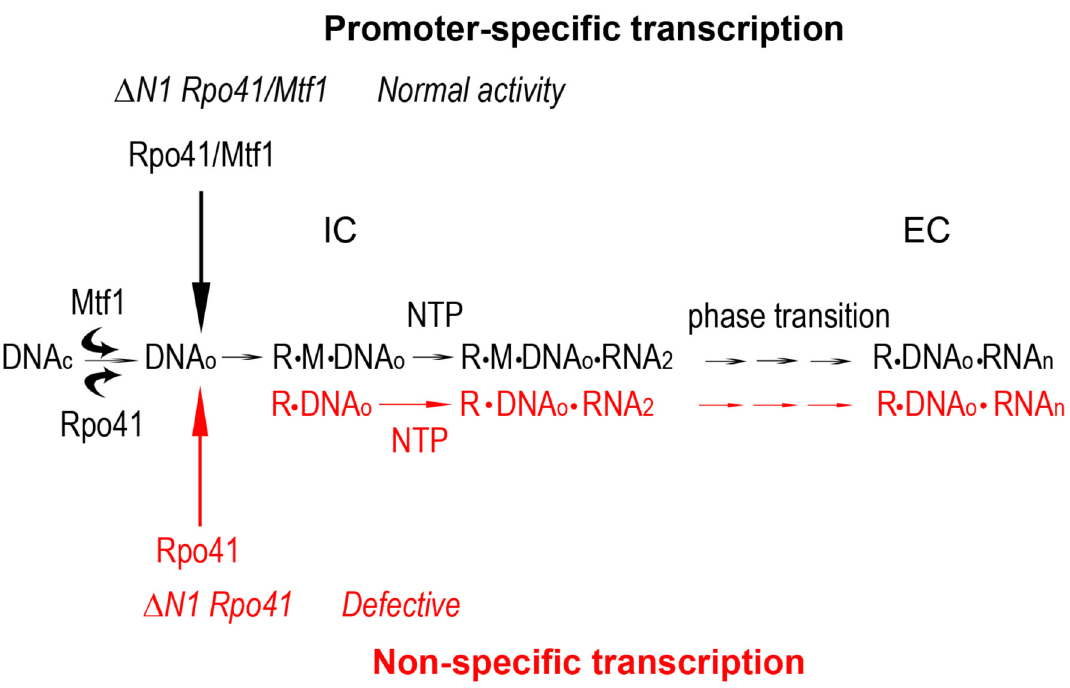
Fig 7. Summary of Rpo41 and Mtf1 roles in RNA transcription. The Rpo41 exhibits promoter-specific activity on closed or open template in the presence of Mtf1 (black pathway). The holoenzyme containing Rpo41 Δ N1 deletion mutant presents normal activity. However, Rpo41 alone exhibits only non-specific activity on both closed and open promoter (red). Rpo41 Δ N1 deletion mutations alone are defective in